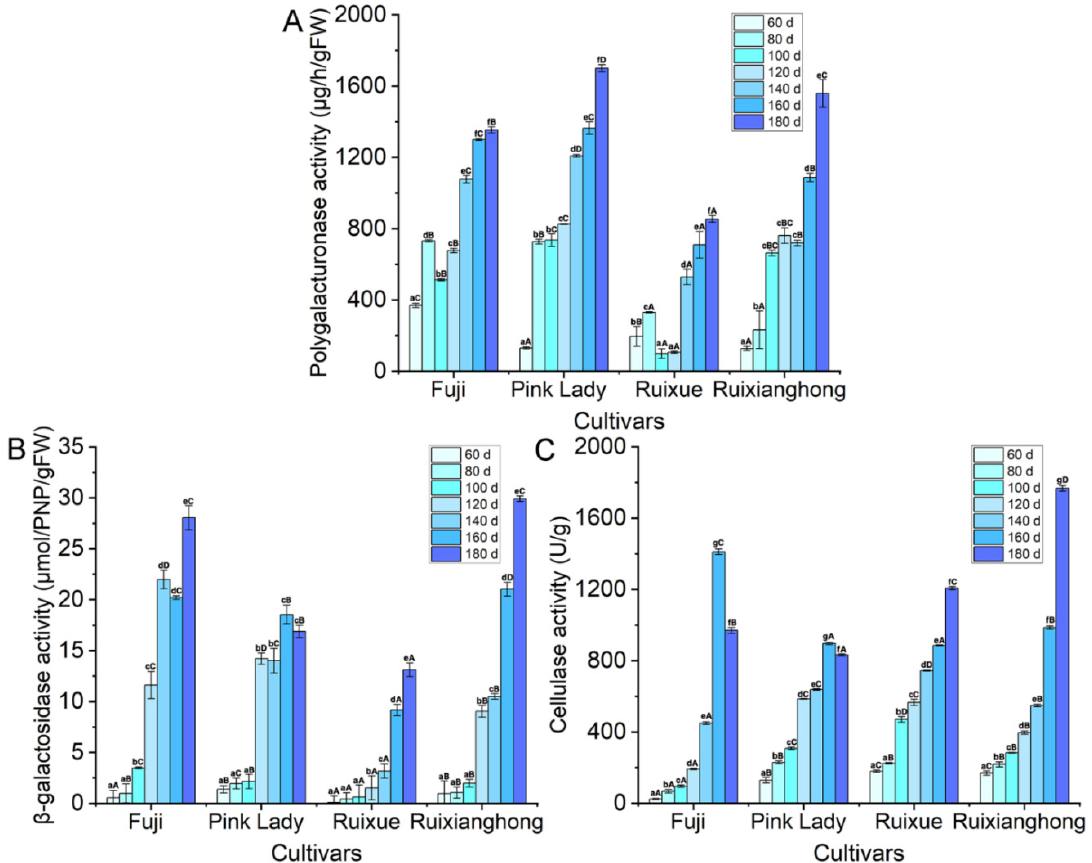
Figure 4. Changes of cell wall degrading enzymes activity in the ‘Ruixue’ and ‘Ruixianghong’ varieties and their parents apples during fruit development and ripening. ( A ) Polygalacturonase (PG), ( B ) β‐ galactosidase ( β‐ gal), and ( C ) cellulase (CEL). Data are presented as means from three independent experiments; the vertical bars indicate the standard error of the mean. Different lowercase letters in columns denote significant differences between sampling dates for each cultivar by Duncan’s multiple range test ( p < 0.05). Different capital letters in columns denote significant differences by Duncan’s multiple range test ( p < 0.05) among different cultivars. Different colors represent different periods.